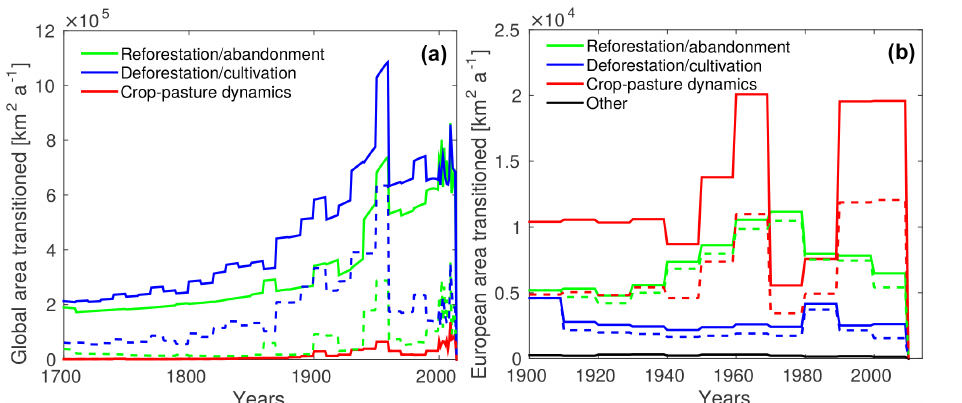
Figure 4. Annual area transitions for major land change processes for global ( a , data from LUH1) and European ( b , EU27 + CH, data from HILDA) gross (solid lines) and net (dashed lines) datasets. The class “other” in (b) includes transitions between natural vegetation and barren land represented in the HILDA